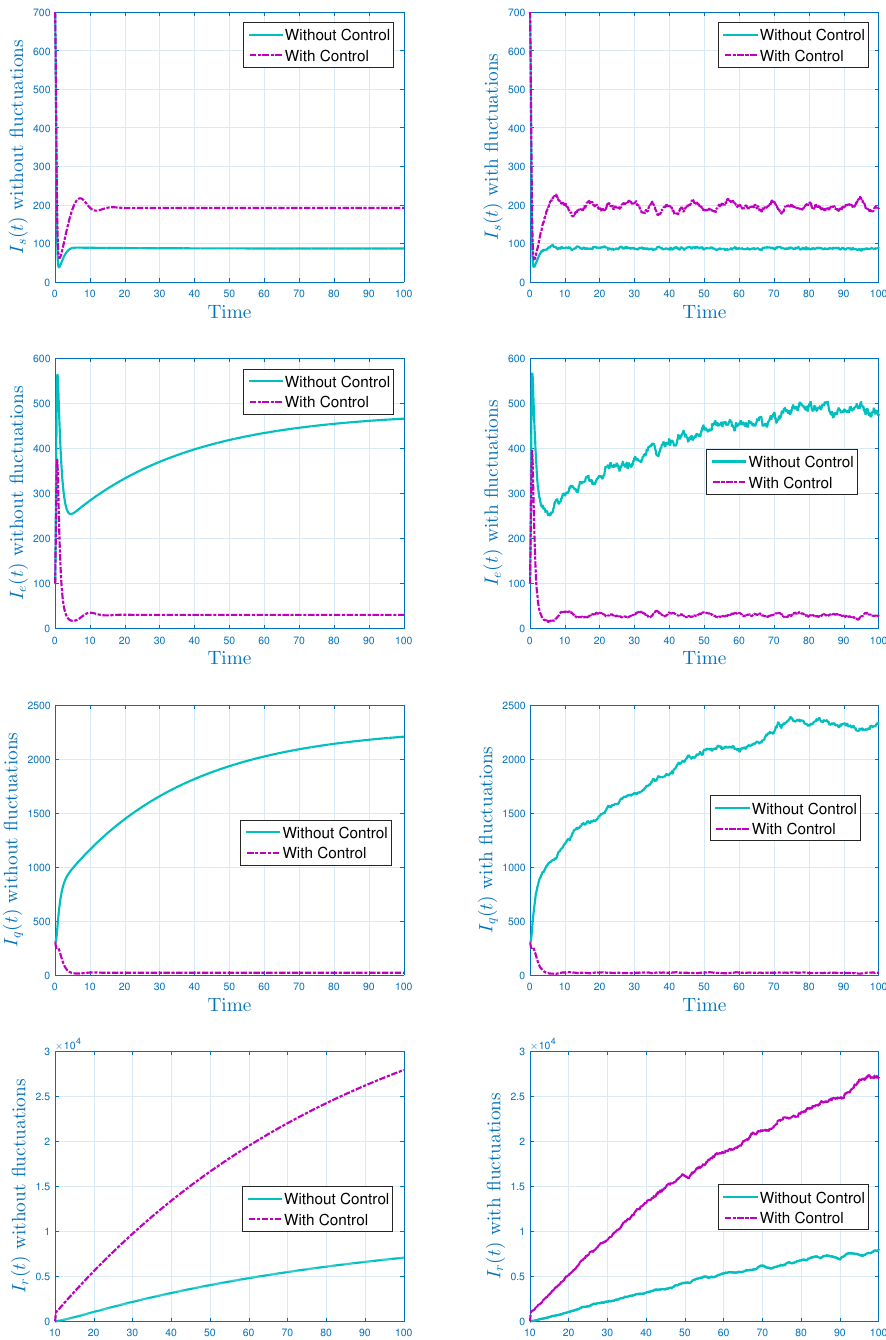
Figure 8. The long-run behavior of the Ebola without and with control strategies: (first column) curves achieved from the solution of the deterministic system and (second column) trajectories of the random